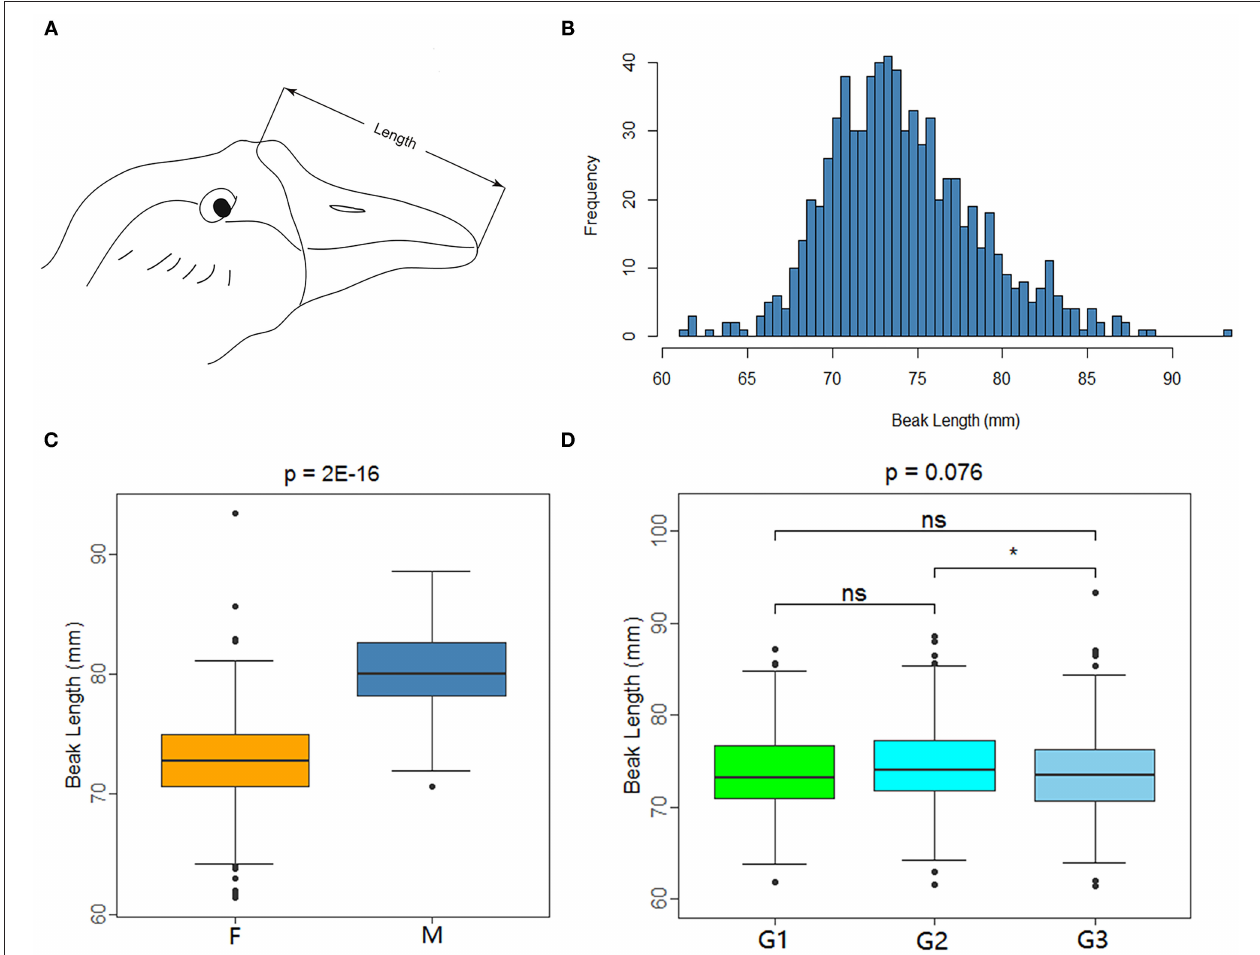
FIGURE 1 | Measuring method and data characteristics of beak length in XGG population. (A) Beak length measurement diagram. (B) Histogram of the frequency distribution of beak length. (C,D) Are box plots of factors associated with beak length measurement. F and M represent female and male (C) , and G1, G2, and G3 represent the three measurement groups (D) . *Indicates significance ( P < 0.05), whereas “ns” indicates no